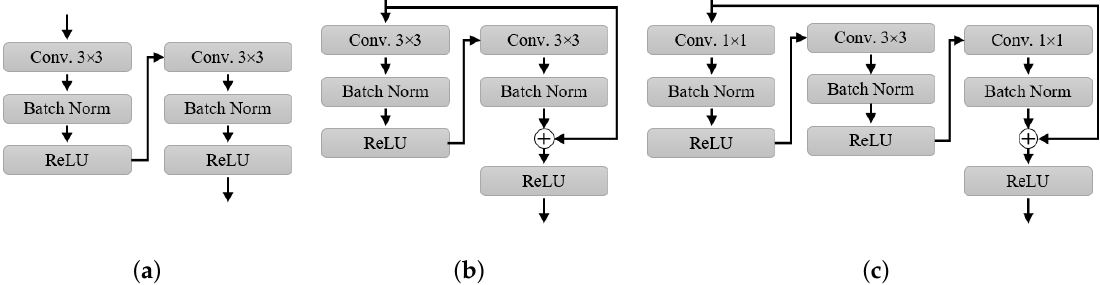
Figure 4. Convolution blocks applied to the proposed methods. From left to right: ( a – c ) are the VGG, ResNet, and Bottleneck structures,